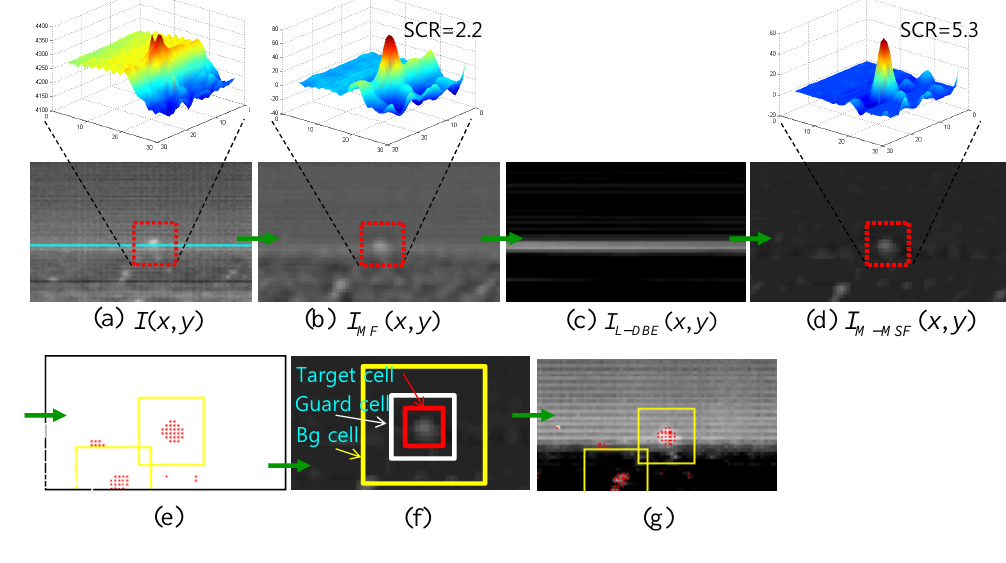
Visualization of horizontal clutter removal and detection flow: ( a ) input image; ( b ) matched filter; ( c ) horizontal line clutter estimation; ( d ) modified (M)-MSF results; ( e ) pre-thresholding; ( f ) signal-to-clutter ratio (SCR) computation region; and ( g ) final detection results using the SCR